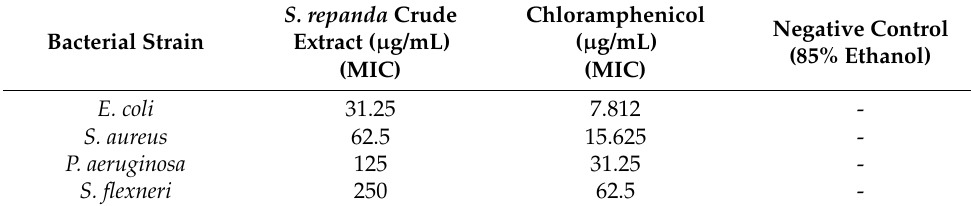
Table 1. Antibacterial activity of S. repanda crude extract.